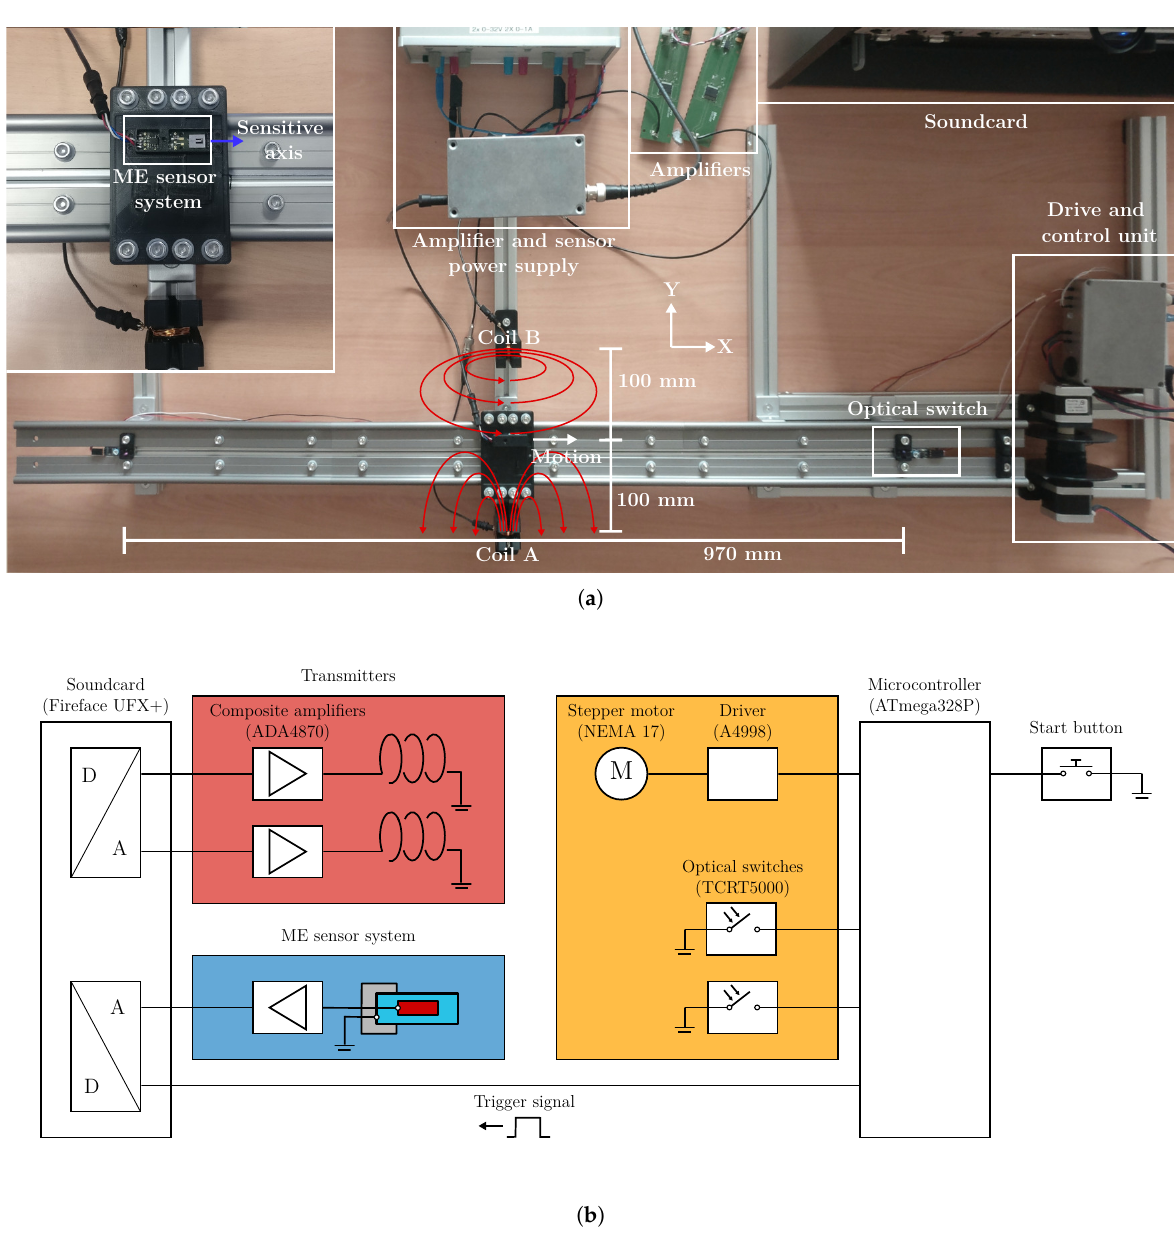
Figure 7. Experimental setup for magnetoelectric motion sensing. ( a ) Overview of the experimental setup. ( b ) Block diagram of key functional